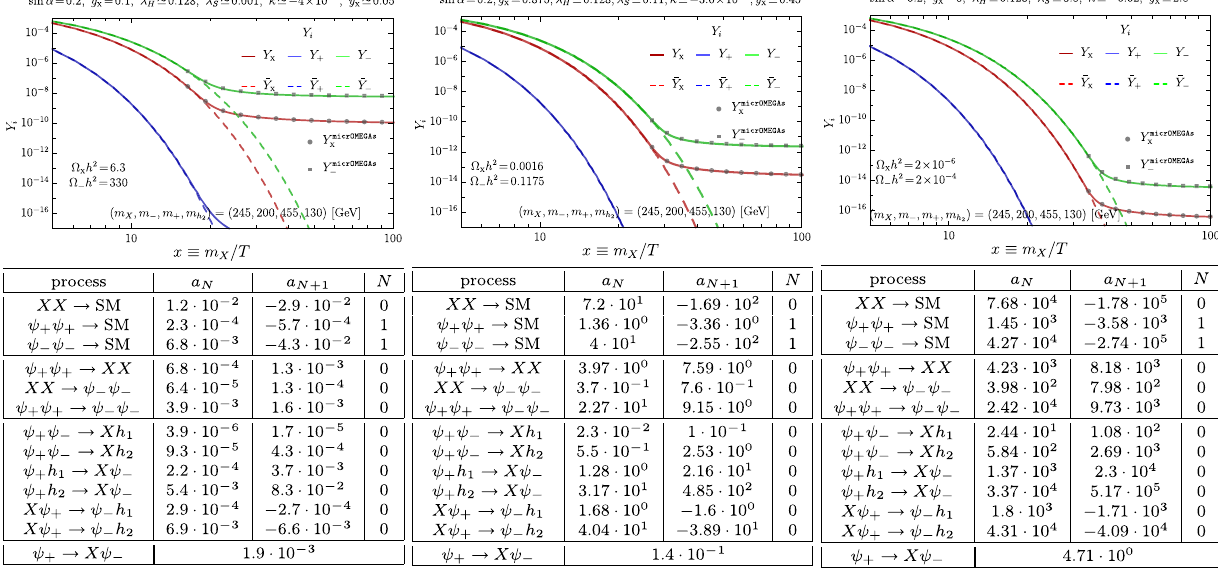
Fig. 7 Solutions of the Boltzmann equations for three sample points from the 2CDM case where X μ and ψ − are stable are shown in the upper panels. These plots show the evolution of the dark matter par- ticle yield Y i ( x ) ≡ n i / s ( n i is the number density, s is the total entropy density and x is defined as x ≡ m X / T ) for different species i = ψ + ,ψ − and X μ . The colored curves are obtained by making use of a dedicated C++ code to solve the corresponding Boltzmann equa- tions, whereas the gray points are the corresponding results from the